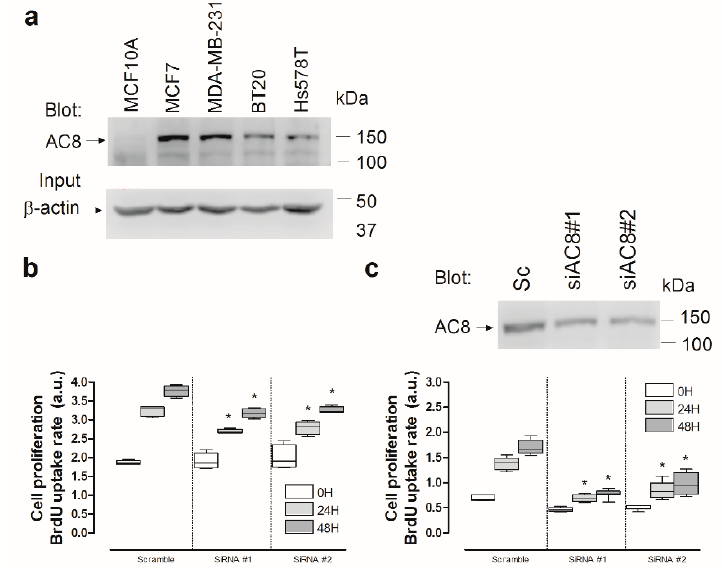
Figure 11. Role of AC8 in triple-negative breast cancer (TNBC) cell proliferation. ( a ) Non-tumoral breast epithelial MCF10A, luminal MCF7 breast cancer, and TNBC cells (MDA-MB-231, BT20, and Hs578T) were lysed and subjected to Western blotting with anti-AC8 antibody, followed by reprobing with anti- β -actin antibody for protein loading control. ( b , c ) MDA-MB-231 ( b ) and Hs578T ( c ) cells were transfected with siAC8#1, siAC8#2, or scramble plasmid (Sc), as indicated. Forty-eight hours later, cell proliferation was assessed for a further 24 and 48 h using the bromodeoxyuridine (BrdU) cell proliferation assay kit, as described in Section 4. The box plot represents cell proliferation 0, 24, and 48 h after cell transfection, presented as BrdU uptake rate; * p < 0.05 compared to the corresponding control (cells transfected with scramble plasmid). ( c , top panel) Hs578T cells were lysed and subjected to 10% SDS-PAGE and Western blotting with anti-AC8 antibody. Blots are representative of three separate experiments.